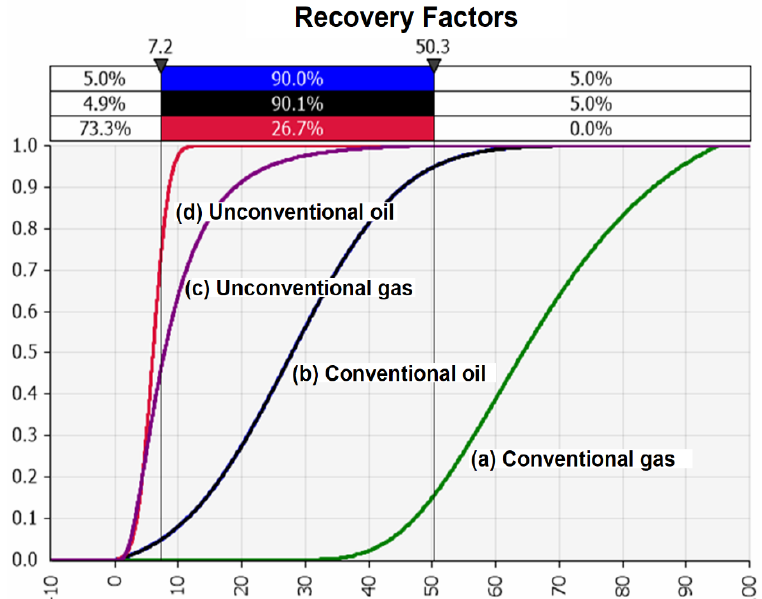
Figure 10. Overlay of four pdfs representing the likelihood of recovery factors for hydrocarbons in place from (a) conventional gas, (b) conventional oil, (c) shale gas, and (d) shale oil. Curves (a) and (b) are based on primary data by Laherrere [51]. Curves (c) and (d) were inferred by shifting the distributions to the left and using recovery factor constraints from unconventional shale plays cited in the literature.